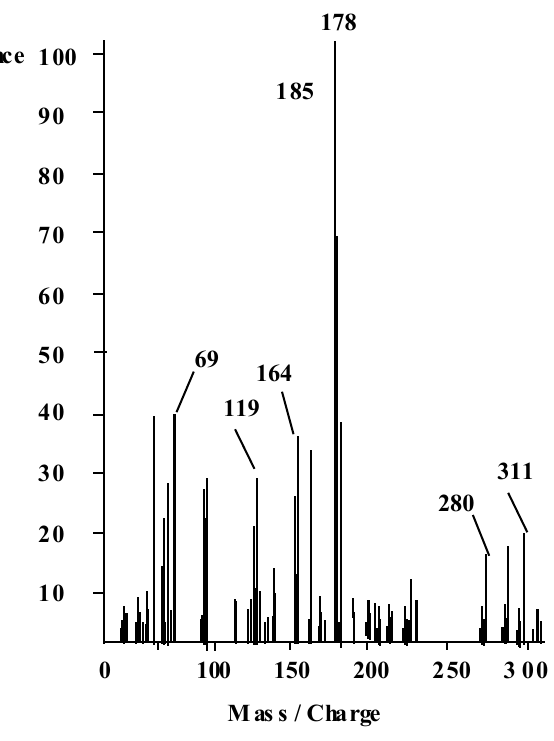
Figure 2. Mass spectrum of HL ligand recorded at 300 °C and 70 eV.